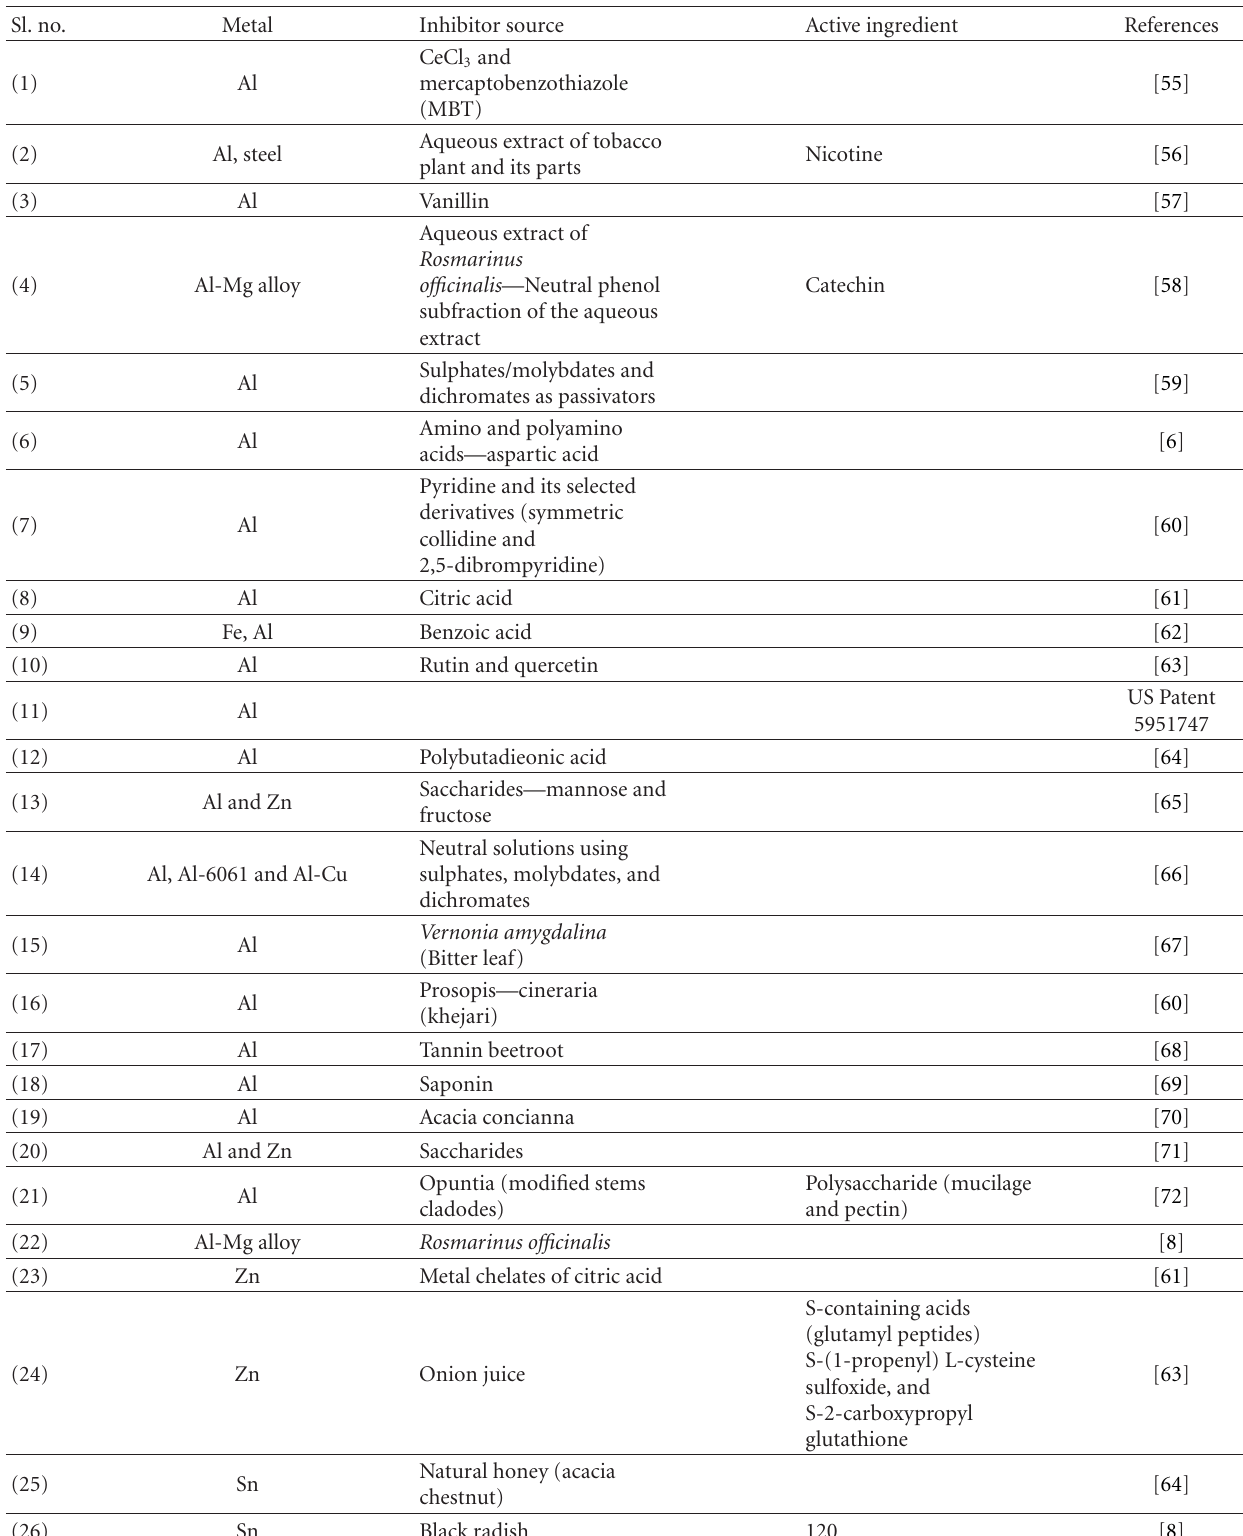
Table 2: Green Inhibitors used for corrosion inhibition of aluminum, aluminum alloys, and other metals and alloys. Sl.